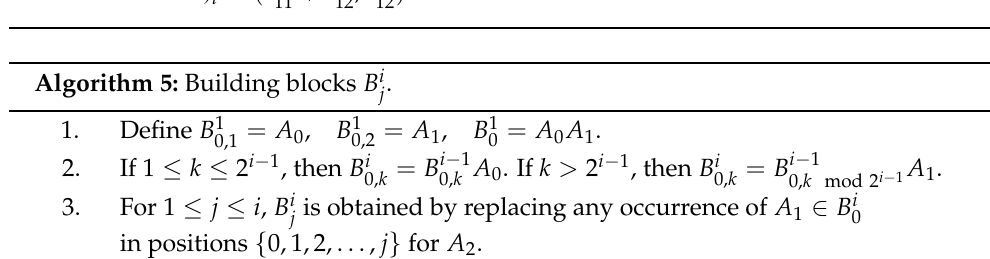
Algorithm 5: Building blocks B i